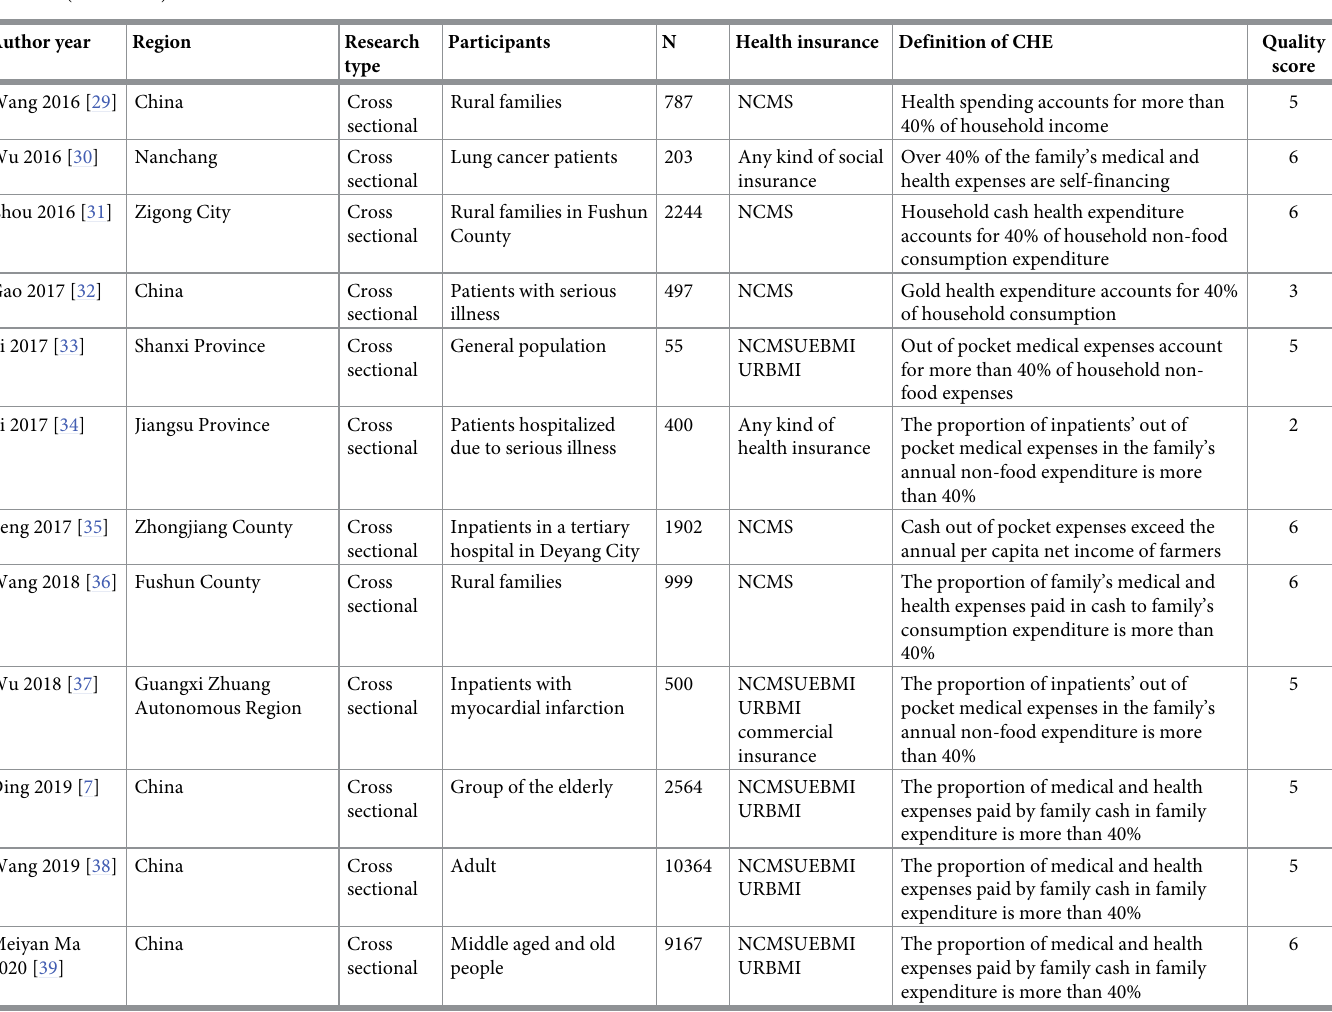
7.8% (4.3%, 11.3%) from 2007 to 2009, 11.2% (8.2%, 14.3%) from 2010 to 2012, 19.2% (18.1%, 20.3%) from 2013 to 2016, 43.9% (25.0%, 62.8%) from 2017 to 2020. Since 2010, the rate of CHE in the population with health insurance was significantly lower than those without. Although both of them were on the rise, the rate of CHE in the population without health insurance was increasing faster and the gap between the two became wider (Fig 5). Secular trend of catastrophic health expenditure by type of insurance The results showed that the rate of CHE of all subgroups increased with time. The CHE rate of people who did not participate in the health insurance increased more and faster, especially after 2013, followed by NCMS, UEBMI and URBMI. Due to lack of data, the trend of CHE rate of commercial health insurance could not be obtained (Fig